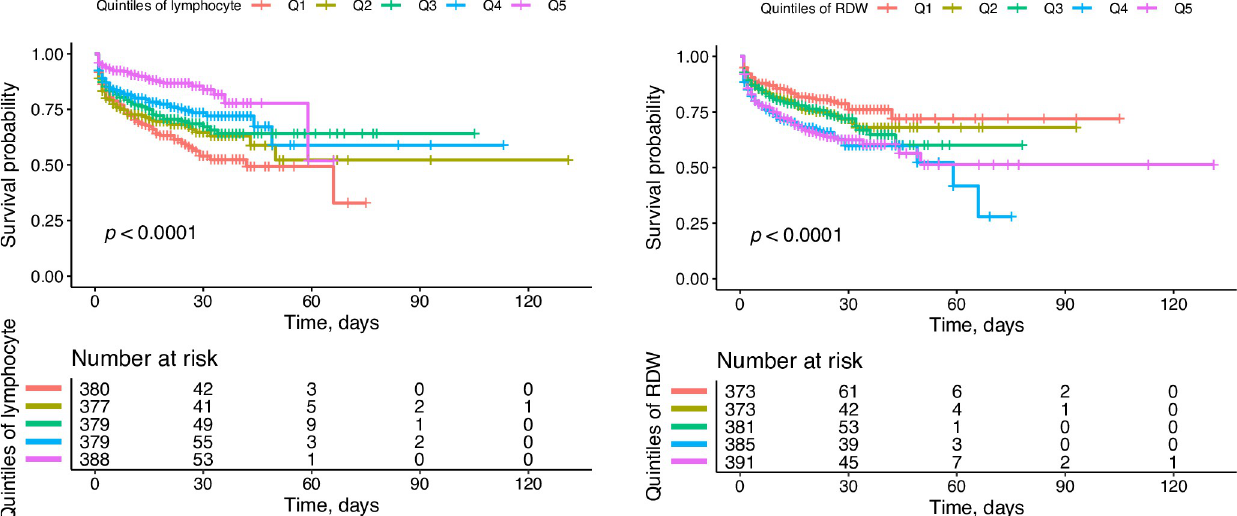
Fig 3. Kaplan–Meier survival curve of AAD in-hospital mortality showing that outcomes significantly varied among the groups of patients with the different quintiles categories of lymphocyte percentage and RDW level ( P < 0.0001 log-rank tests). AAD, acute aortic dissection; RDW, red blood cell distribution width.